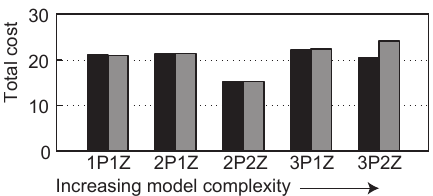
Figure 3. Predictive skill for five ecosystem models of different complexity, after assimilation of satellite data (black) and after as- similation of satellite data with 20% added noise (grey) (Xiao and Friedrichs, 2014a). The most complex model appear to be the most sensitive to errors in the data, in terms of its cross-validated predic- tive